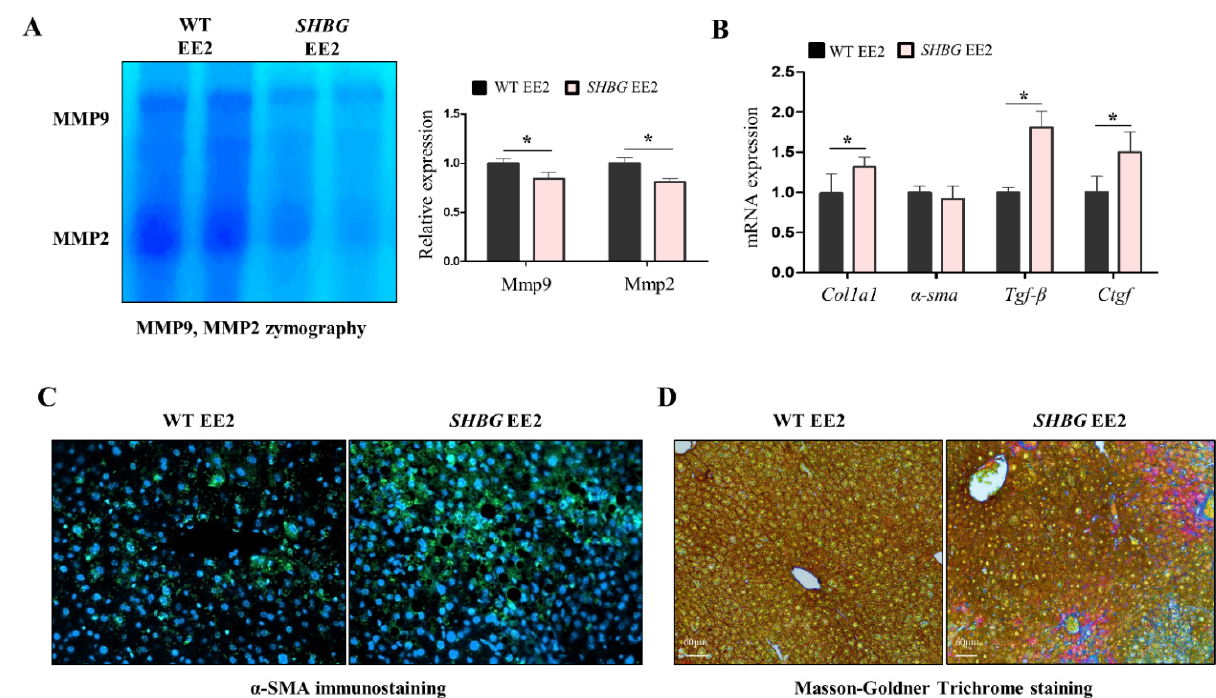
Figure 3. Hepatic fibrosis was induced in SHBG mice fed with EE2. ( A ) Zymographic analysis and quantification of MMP9 and MMP2 in livers of WT EE2 and SHBG EE2 mice. ( B ) mRNA expression of Col1a1, α -Sma , Tgf- β , and Ctgf in livers of WT EE2 and SHBG EE2 mice. Rplp0 was used for an internal control. ( C ) Immunostaining of α -SMA (green) in livers of WT EE2 and SHBG EE2 mice. DAPI staining was used for an internal nucleus control. ( D ) Masson-Goldner Trichrome staining in livers of WT EE2 and SHBG EE2 mice. Fibers were stained with bright red. Scale bar; 60 µm. Numbers of mice used for experiments were: WT EE2 (8), SHBG EE2 (8). Student’s t -Test was used for analysis. Values represent means ± SD. * p < 0.05. Data were quantified from replicated values in which independent experiments were performed in triplicate at least.